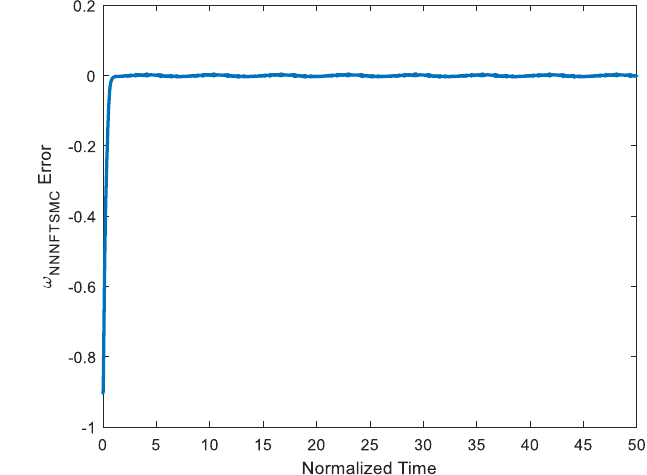
Figure 9. Position error of HTGS using ( a ) SMC and ( b ) proposed controller. Table 2. Results of SMC and NNNFTSMC for step response.